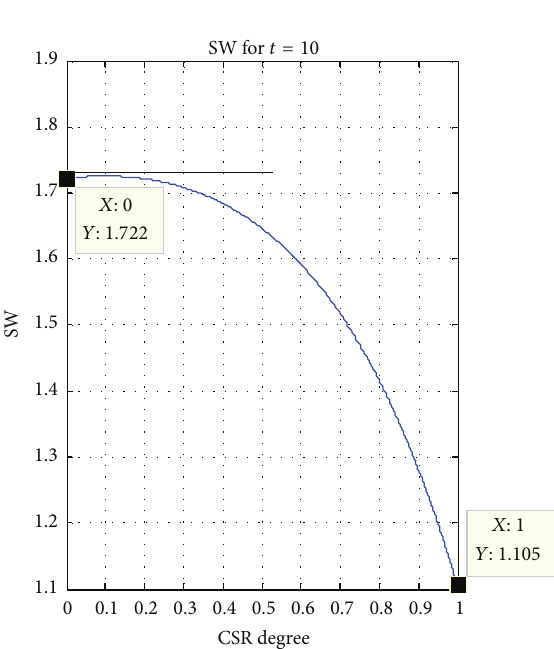
Figure 5: Social welfare for 𝑡 = 6 .